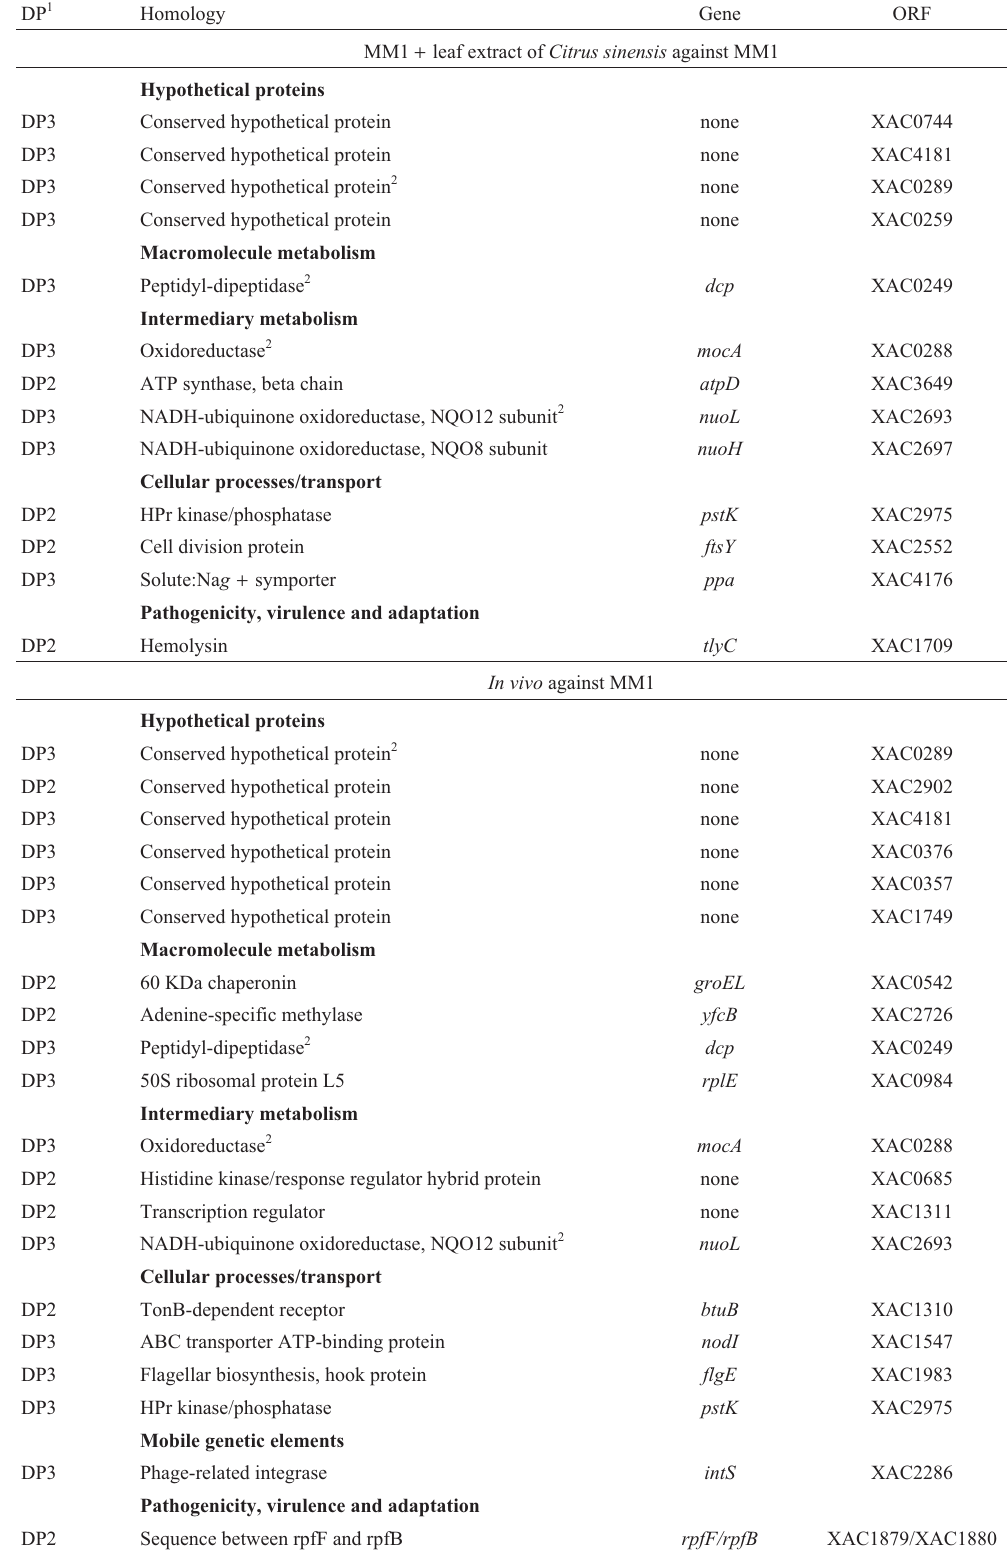
Table 1 - Differentially expressed genes, regulated in the presence of leaf extract and in vivo detected by cDNA